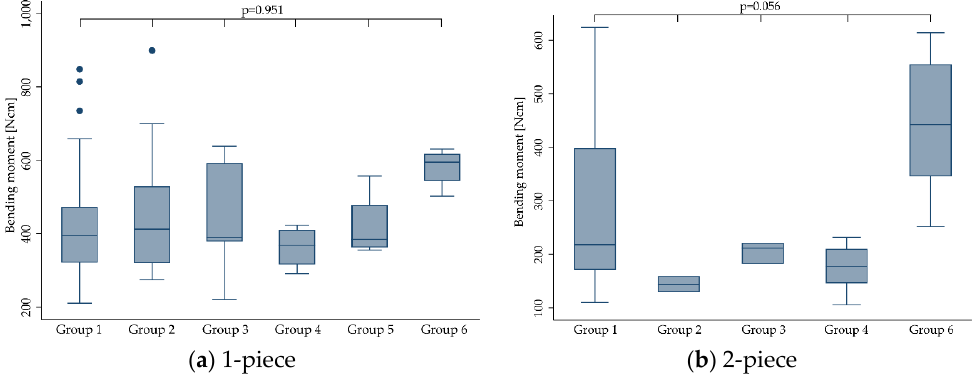
Figure 10. Boxplots showing the bending moment at the time point of fracture depending on dynamic loading conditions respecting the applied load and amount of cycles (as categorized in Section 2.7) for 1- ( a ) and 2-piece ( b ) zirconia implants. Whiskers are used to represent all samples lying within